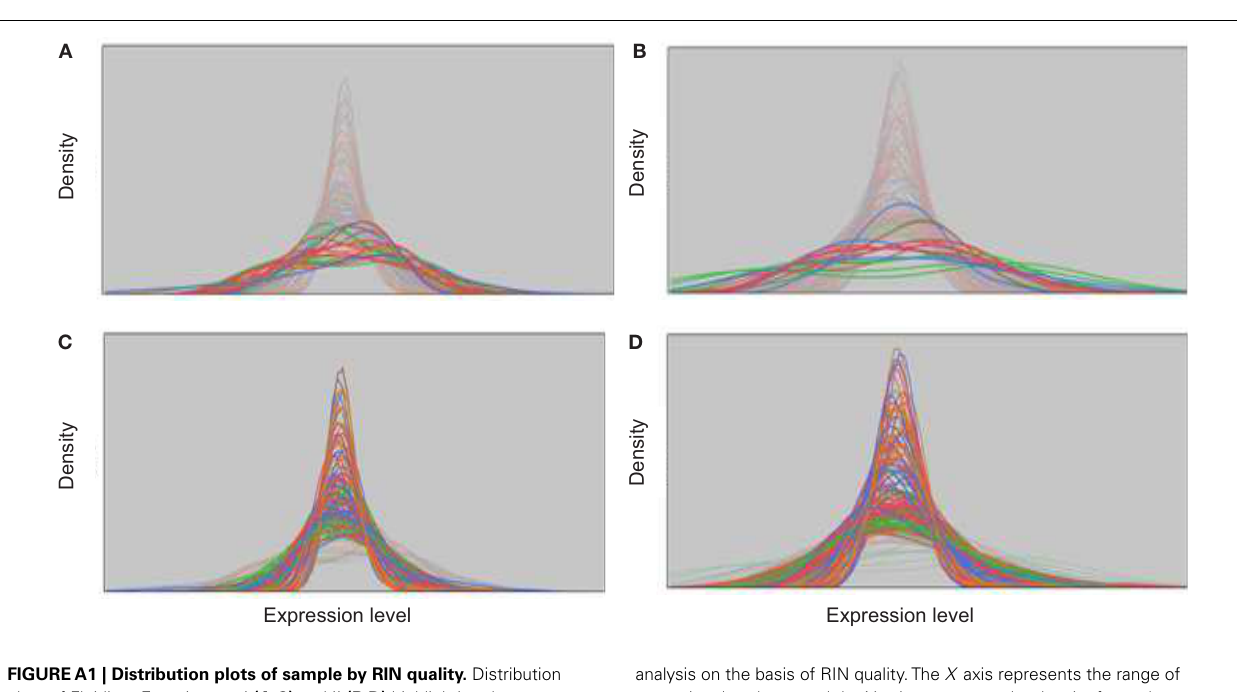
analysis on the basis of RIN quality.The X axis represents the range of transcript abundance and the Y axis represents the density for each